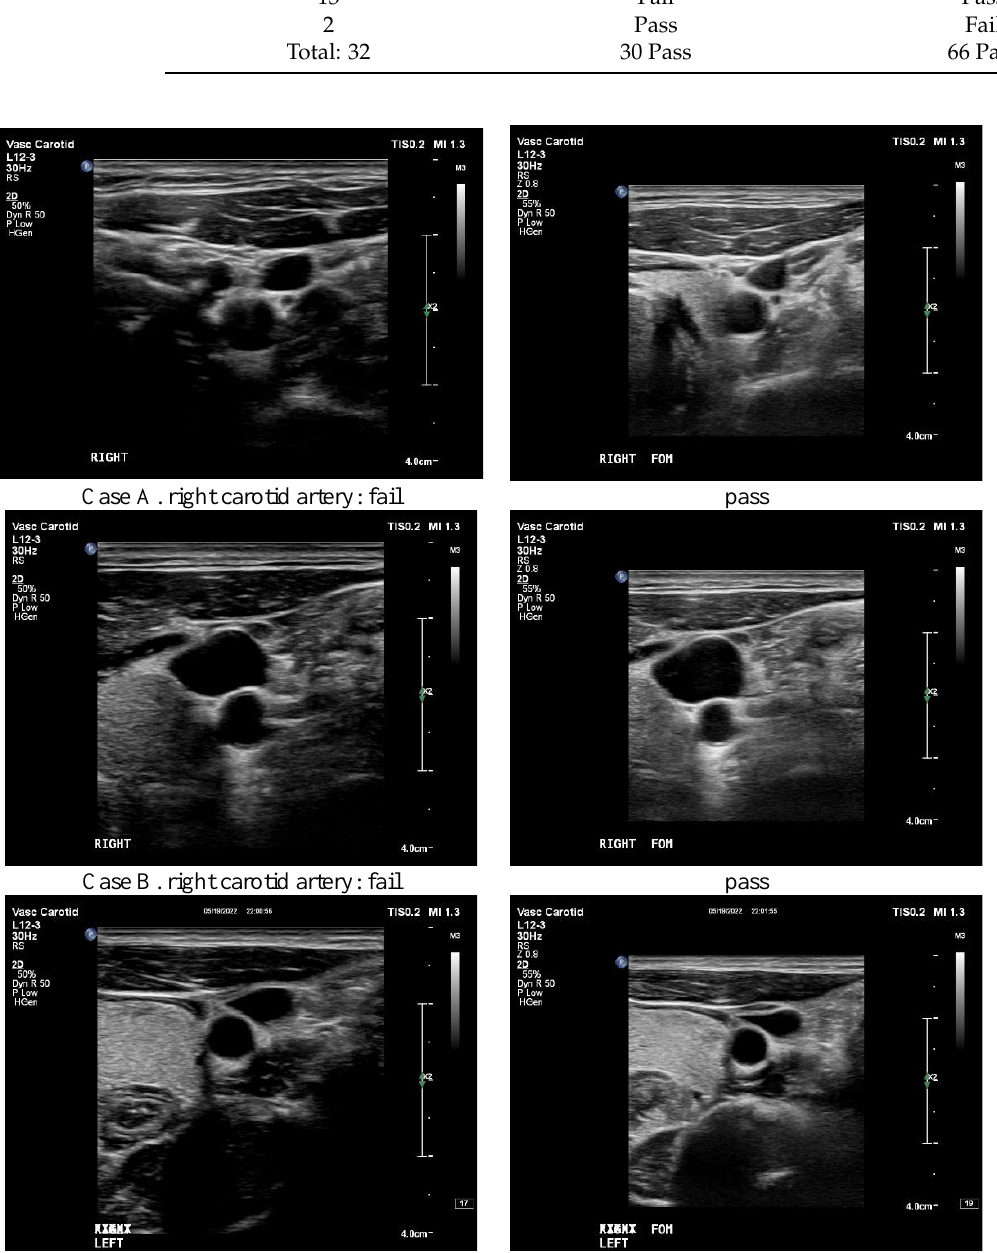
Table 5. Three well-trained radiologists graded the statistical data of 32 scanned images from 5 volunteers. Thus, a total of 192 (32 × 3 × 2 = 192) images were graded by three radiologists. Pair Numbers Conventional Optimal 17 Pass Pass 13 Fail Pass 2 Pass Fail Total: 32 30 Pass 66